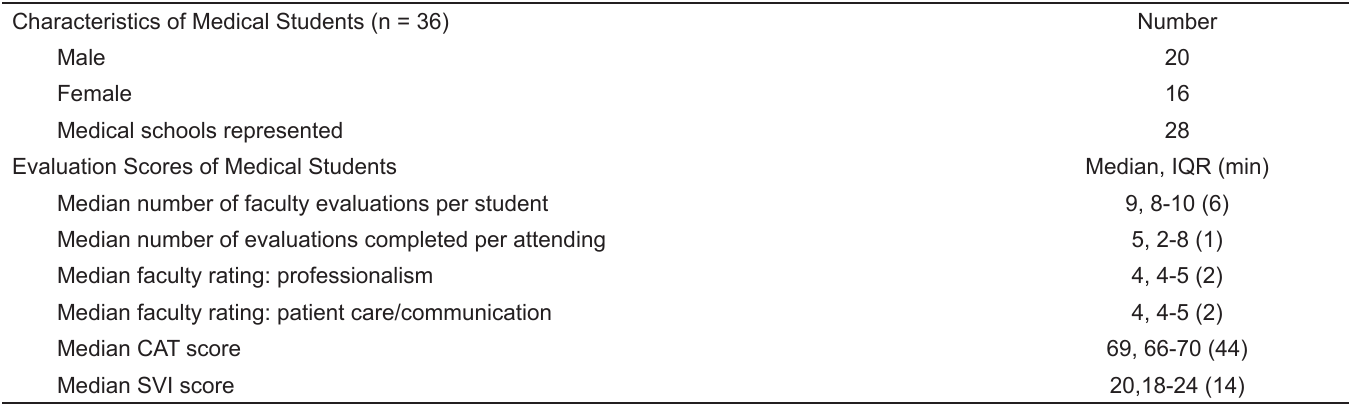
Table 1. Demographic characteristics and evaluation scores of emergency medicine (EM)-bound medical students rotating in an EM clerkship. Medians presented with interquartile range and minimum; means with standard deviation. None of the three scoring methods (faculty evaluation, CAT score, SVI score) had normal distributions (all p values <0.01).